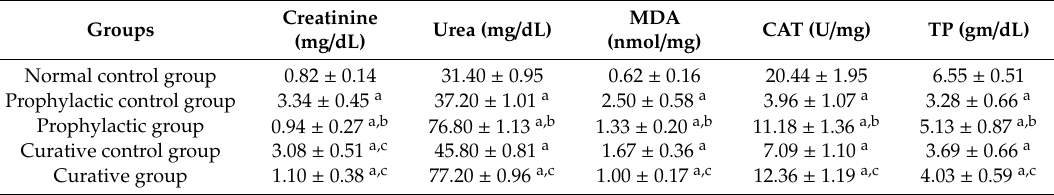
Table 2. E ff ect of Berberis vulgaris root extract ( Bv RE) on cisplatin-induced nephrotoxicity and kidney tissue oxidative status. Serum creatinine and urea levels were measured in mg / dL, serum total protein (TP) in gm / dL, kidney tissue malondialdehyde (MDA) level in nmol / mg protein, and kidney tissue catalase (CAT) in U / mg protein.